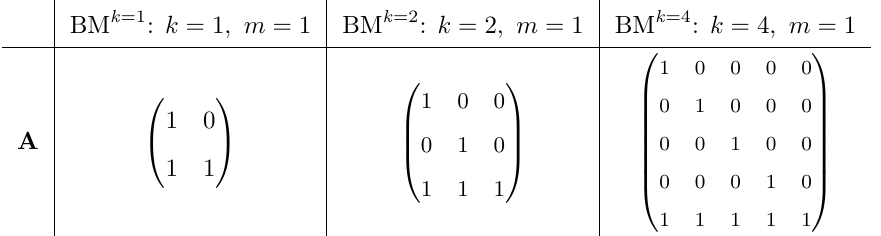
Table 5: Various choices of generator matrices A over F ( k + m ) × n packed code-based masking with n = k + m and m = 1.